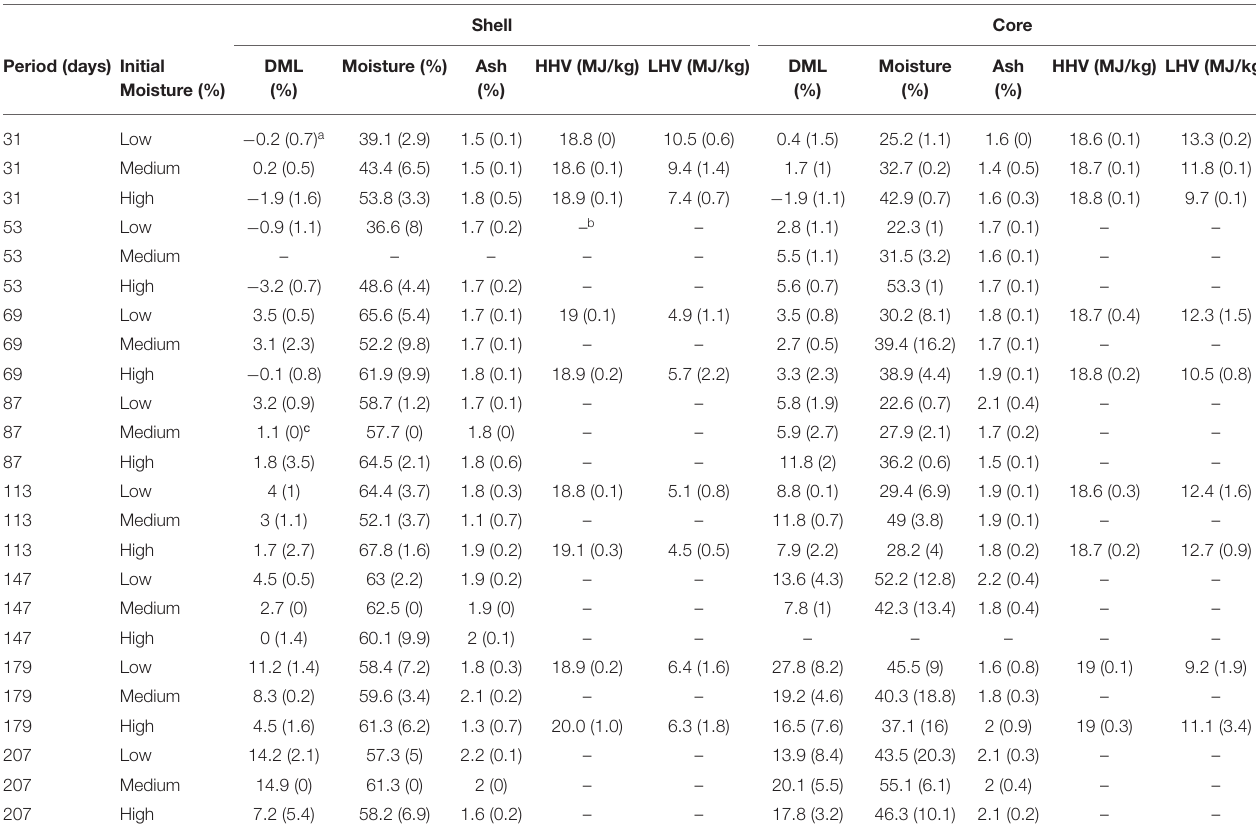
TABLE 5 | Changes in dry matter loss (DML), moisture, ash, higher (HHV), and lower (LHV) heating value for three initial moisture contents of fresh chips (FC) in the core and shell of a leaf-off willow winter storage pile (first day is December, 22nd 2017). Shell